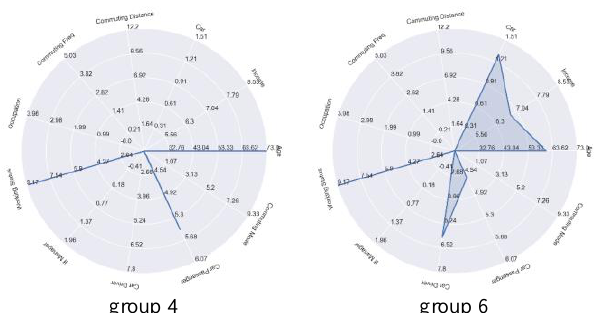
Figure 8. The average demographics of group 4 and 6.